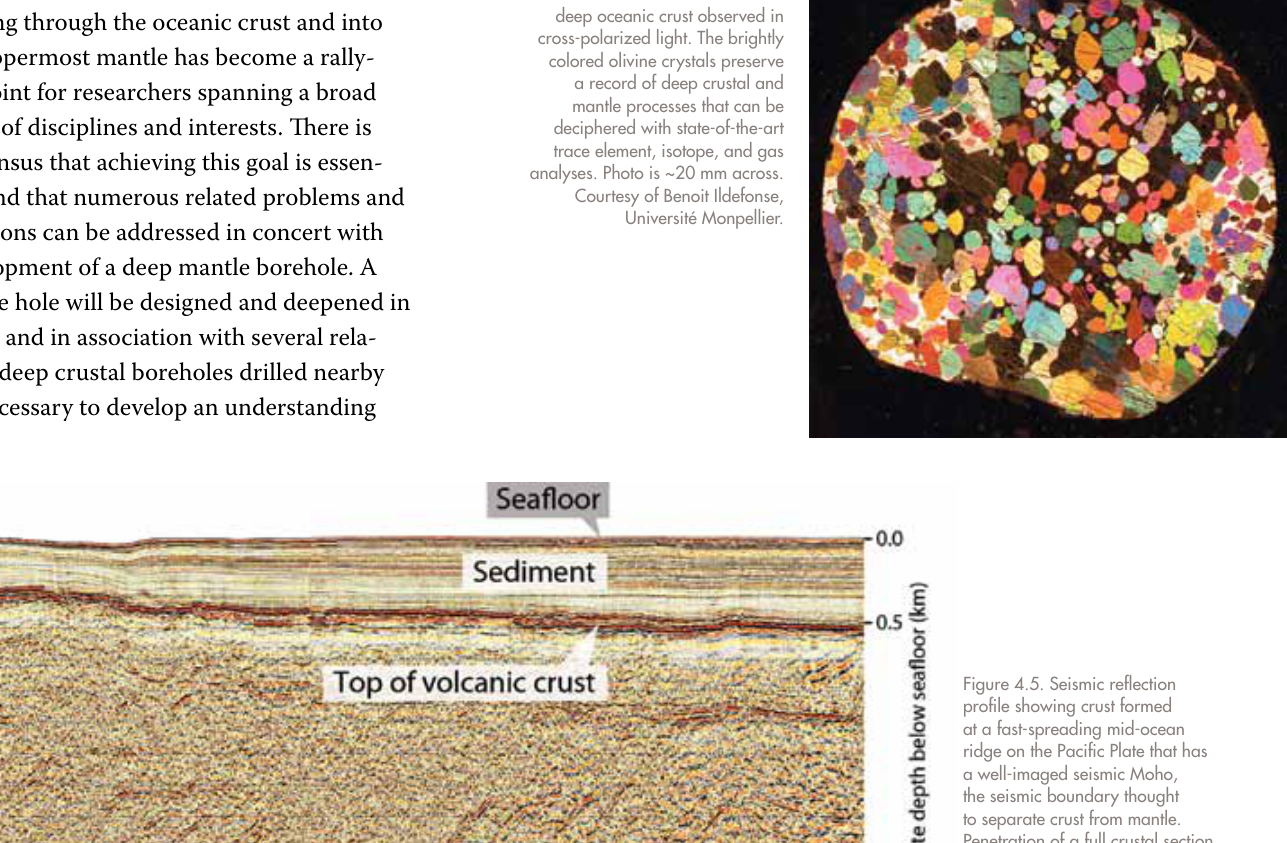
figure 4.5. seismic reflection profile showing crust formed at a fast-spreading mid-ocean ridge on the pacific plate that has a well-imaged seismic moho, the seismic boundary thought to separate crust from mantle. penetration of a full crustal section in an area such as this would extend across the moho and into the upper mantle rocks below. depth is approximate, and is based on this travel-time section. courtesy of s. Kodaira,